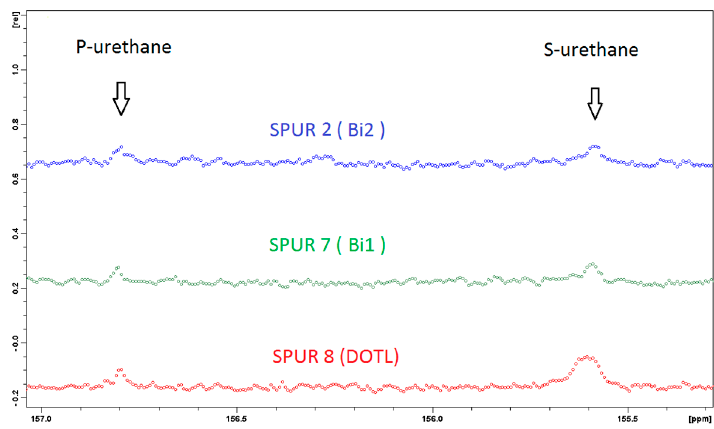
Figure 3. 13 C-NMR spectrum of SPUR 6.